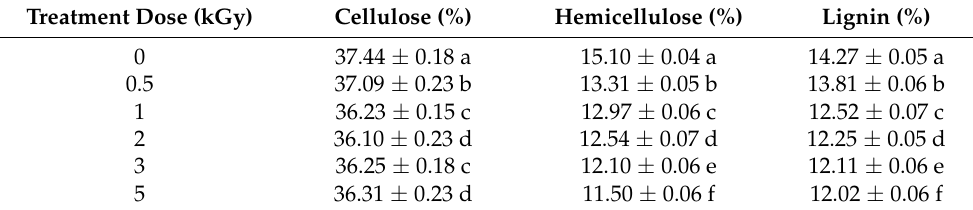
Table 1. Effects of γ -irradiation on the content of main components of pea fiber. Treatment Dose